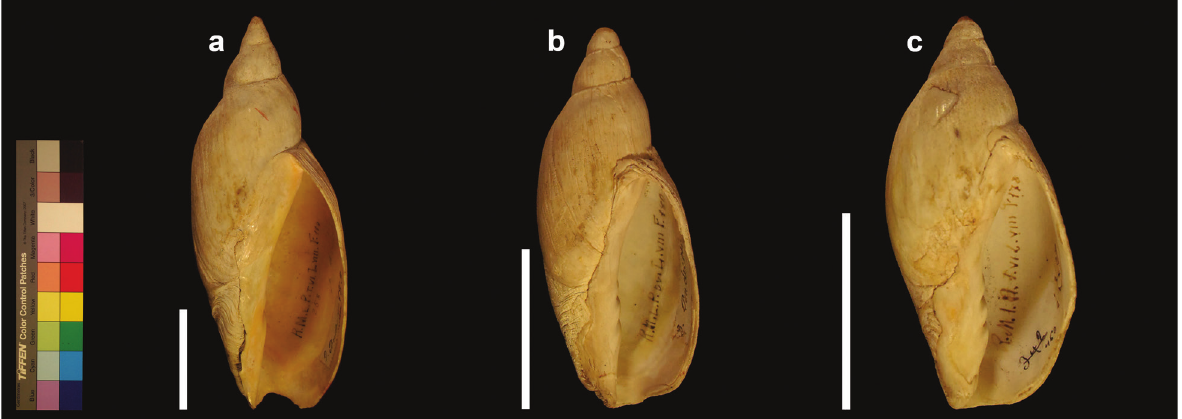
Figure 13. Voluta ancilla ponderosa , specimens figured by Lahille (1895: pl. VIII). a Correspond to fig. 183 b Corresponds to fig. 180 c Corresponds to fig. 178. Scale bars: 5 cm.